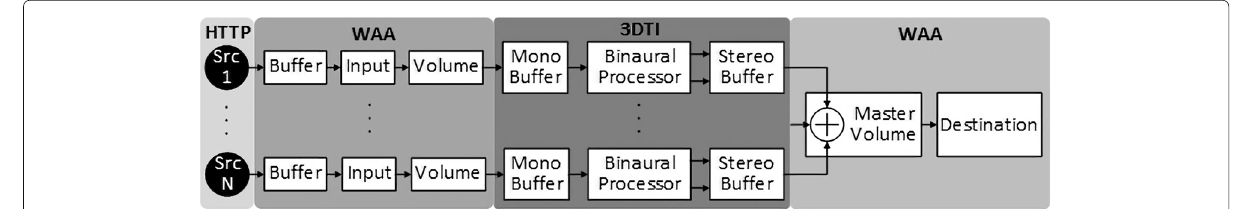
Fig. 2 PlugSonic Soundscape signal